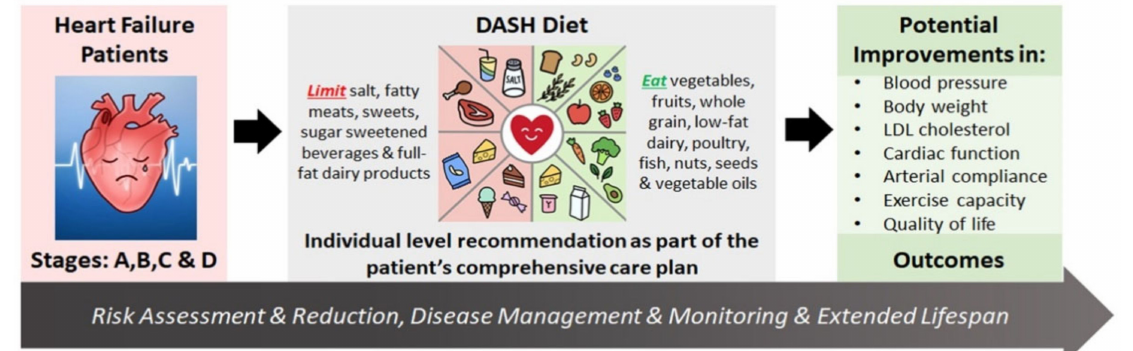
Figure 1. The potential role of the DASH diet in heart failure management. Assessment of patients with heart failure (HF) stages (A–D) is followed by comprehensive clinical care management, which includes an individual-level DASH diet recommendation. Once successfully adopted and adhered to, the DASH diet can improve patients’ physical and functional capacities through reductions in blood pressure, body weight, and LDL cholesterol concentration and improvements in cardiac function, arterial compliance, exercise capacity, and quality of life. The positive effects of the DASH diet implemented as part of a comprehensive care plan for risk reduction and disease management and monitoring can contribute to improved health